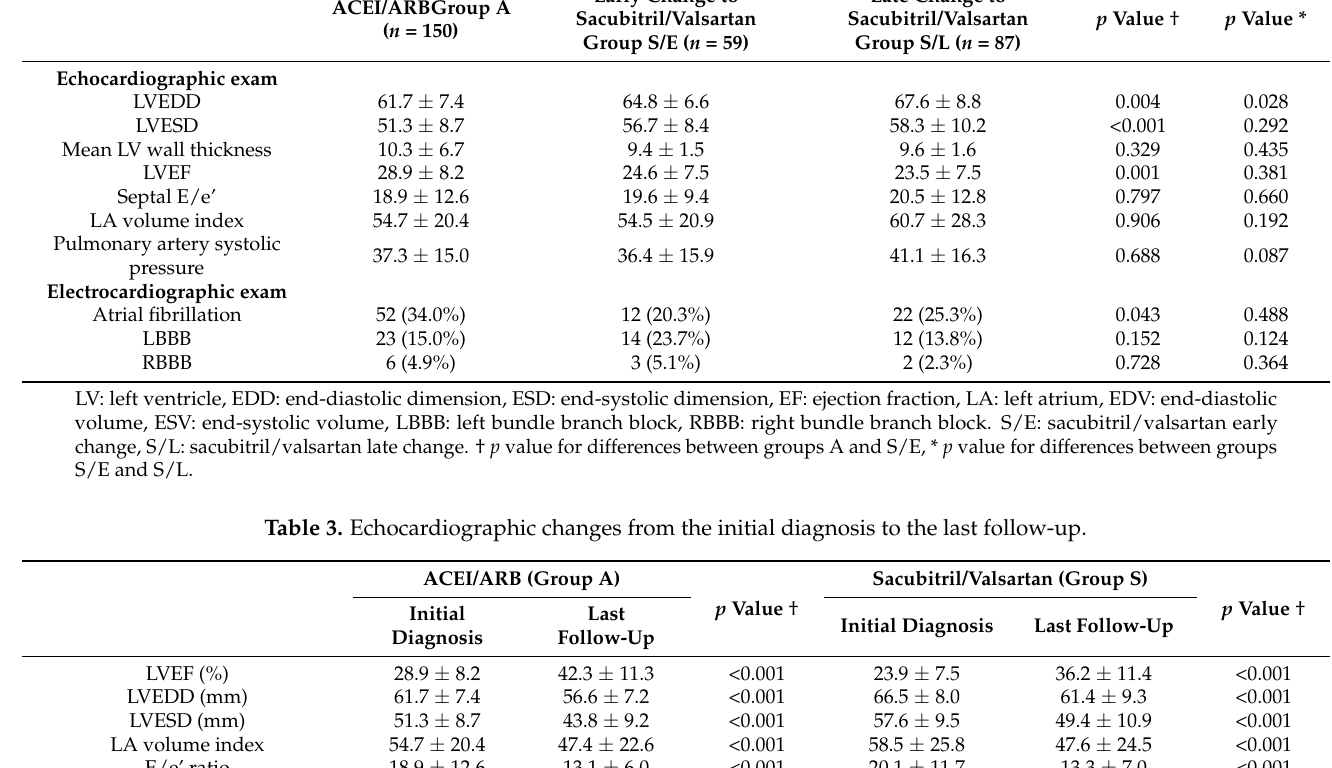
Table 2. Baseline echocardiographic and electrocardiographic exams according to the groups. Early Change to ACEI/ARBGroup A Sacubitril/Valsartan ( n = 150) Group S/E ( n = 59)